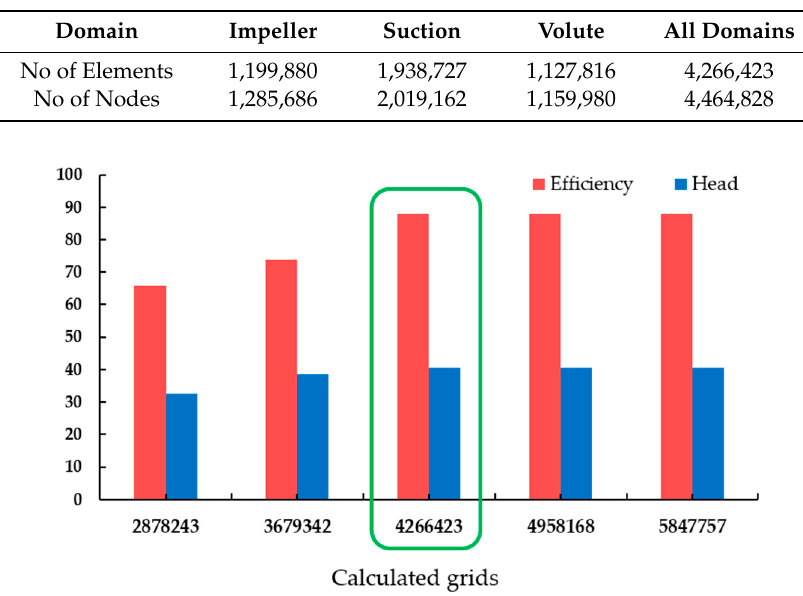
Figure 3. Performance comparison for 5 independent grids.